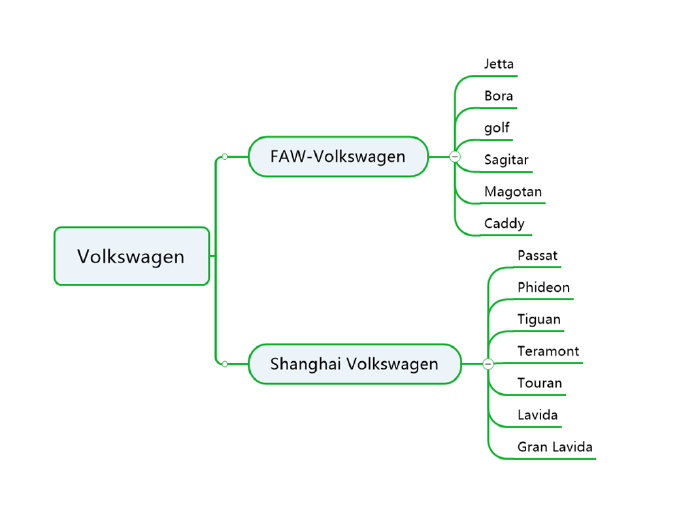
Figure 12. The number of training texts for the relation “Same Level”.